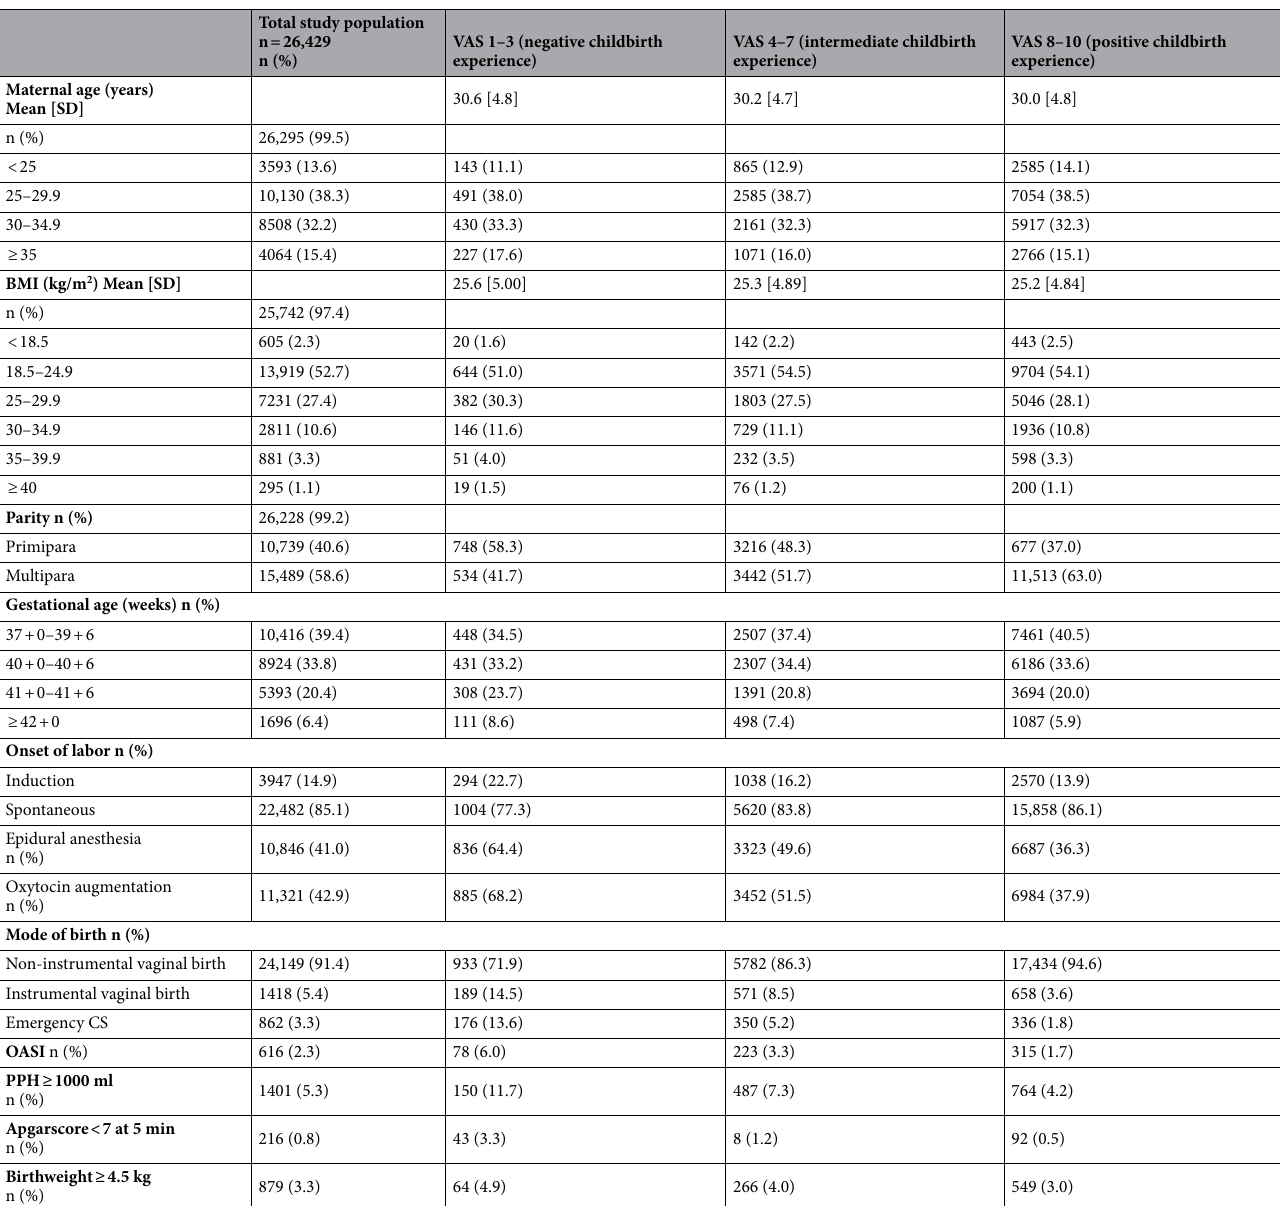
Table 1. Maternal characteristics, obstetric interventions, and outcomes in women with categorized childbirth experiences (VAS). Categorical data are presented as number and (%) and continuous data as mean and [SD]. VAS visual analogue scale, BMI body mass index, CS cesarean section, OASI obstetric anal sphincter injury, PPH postpartum